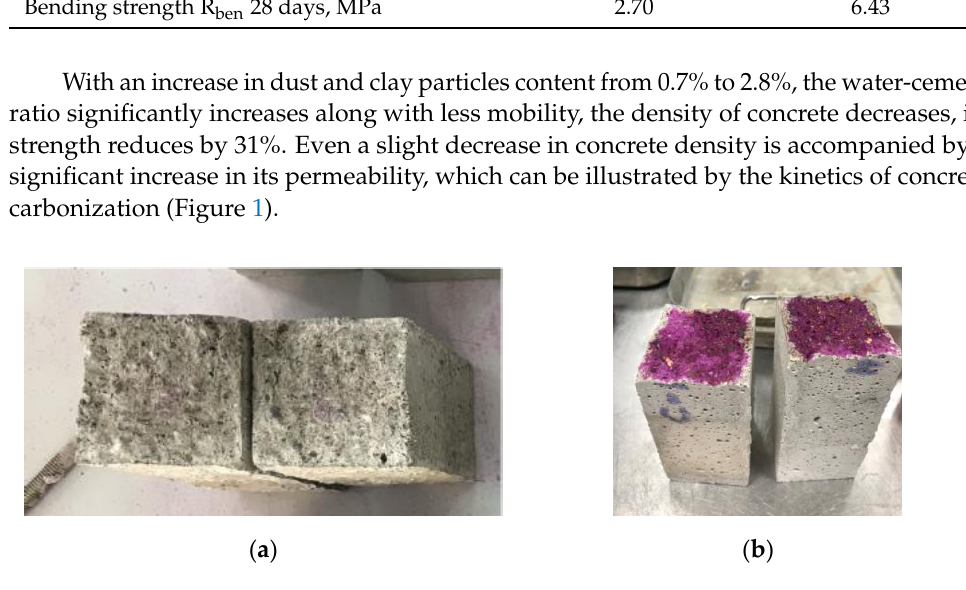
Figure 1. Images of newly made chips of fine-grained concrete coated with an indicator of 0.1 % phenolphthalein solution: ( a ) composition С1–I; ( b ) composition C2-I.